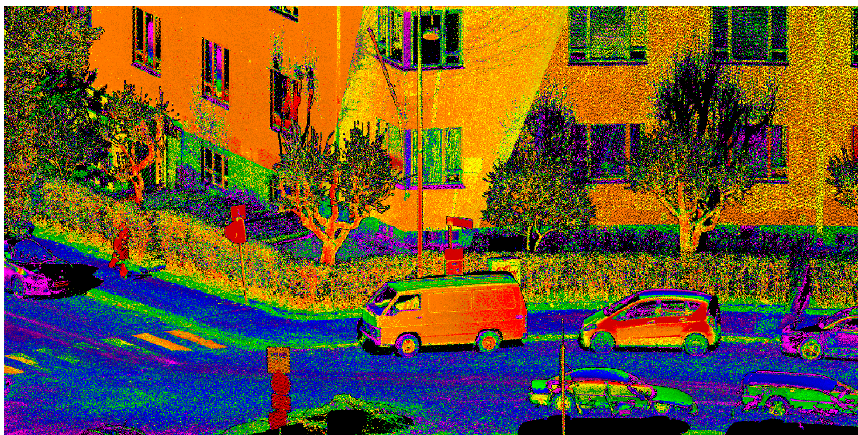
Figure 4. Example road environment data collected with the Riegl VUX-1HA (RIEGL Laser Measurement Systems GmbH, Horn, Austria) with NovAtel SPAN (UIMU-LCI and Flexpak6) IMU (NovAtel Inc., Calgary, Canada). The point cloud has been colorized with laser backscatter intensity.